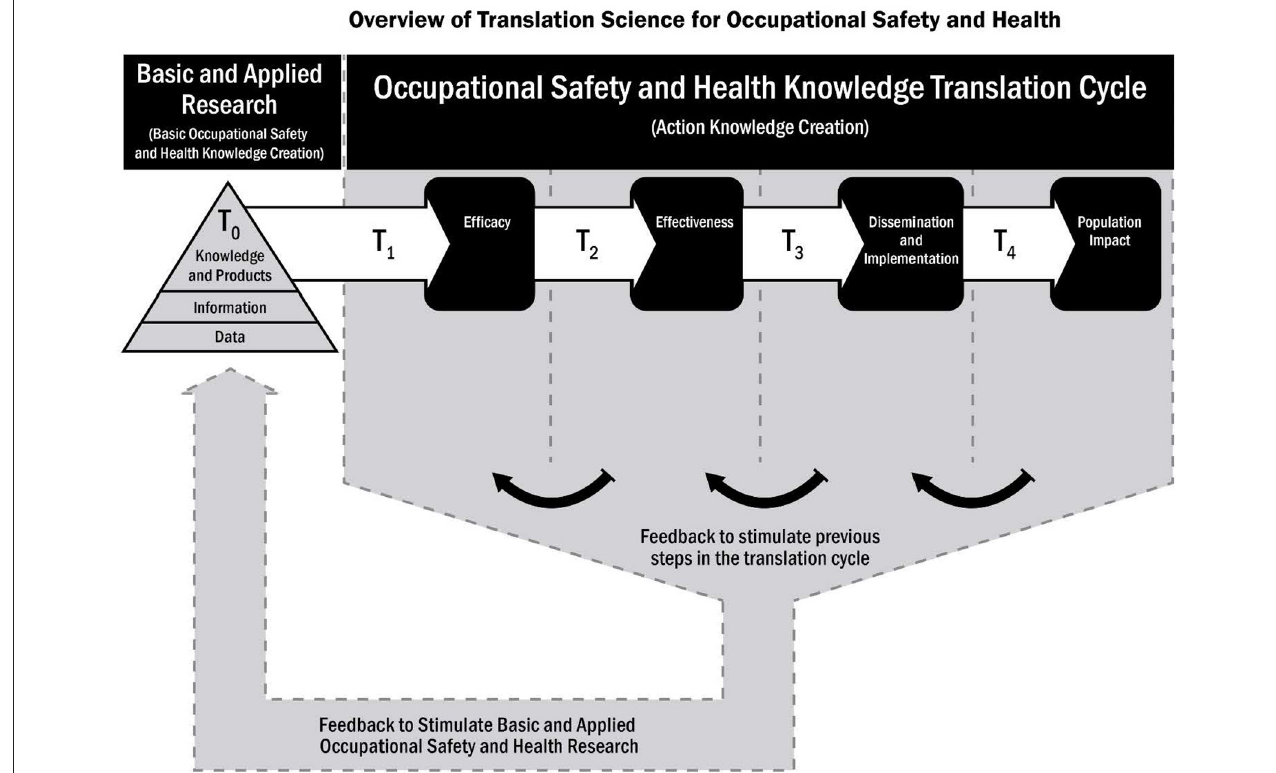
FIGURE 1 | Overview of translational science for occupational safety and health [adapted from Schulte et al. (11)].